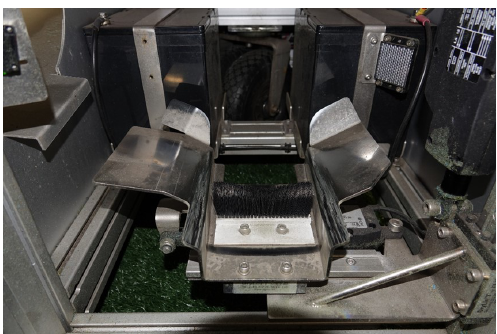
Figure 6. Ball Training Machine—loading tray for balls.